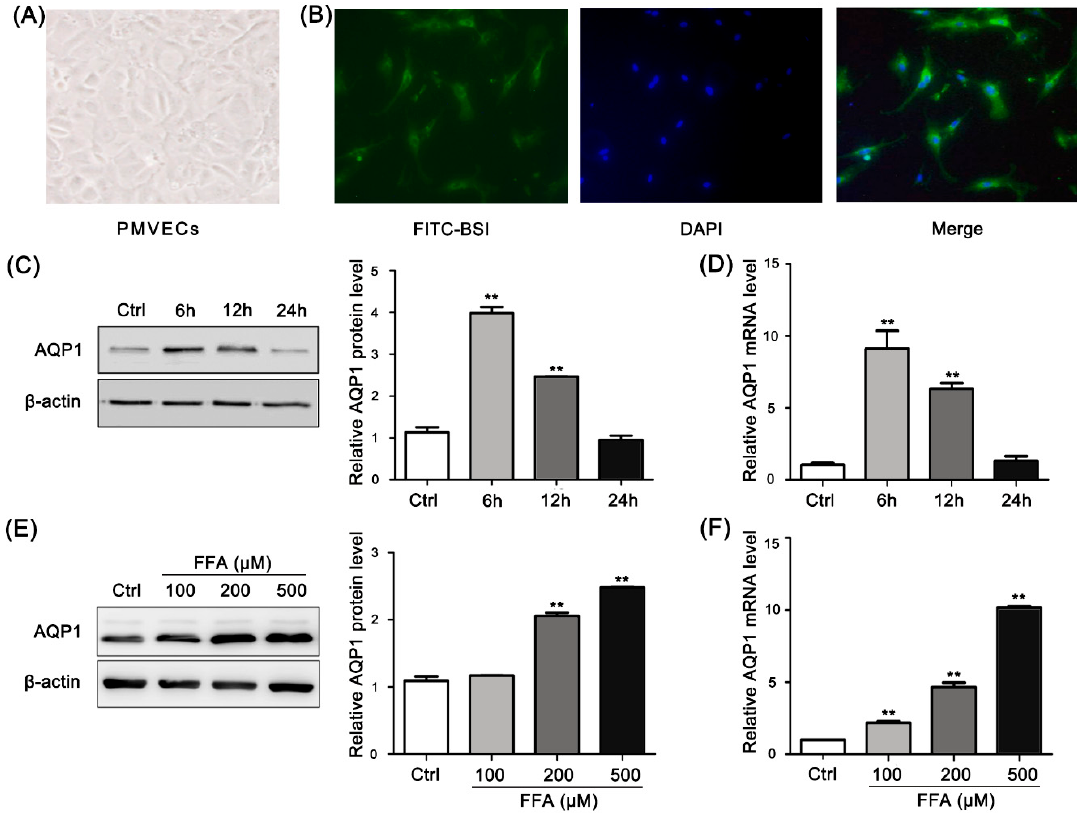
Figure 3. FFA induced up-regulation of AQP1 expression in PMVECs. ( A ) Primary cultured PMVECs obtained from normal rats. The PMVECs were polygonal or fusiform with a uniform size and displayed a similar and typical cobblestone-like morphology. Magnification 200×; ( B ) Fluorescence microscopy showed that the PMVECs exhibited green fluorescence after staining with FITC-BSI. The nuclei were stained blue by DAPI. Magnification 200×; ( C , D ) The protein and mRNA levels of AQP1 in PMVECs stimulated by 500 μ M FFAs for different times; ( E , F ) The protein and mRNA levels of AQP1 in PMVECs stimulated by different concentrations of FFAs for 6 h. ** p < 0.01, the statistics were made by comparing with Ctrl group, respectively.